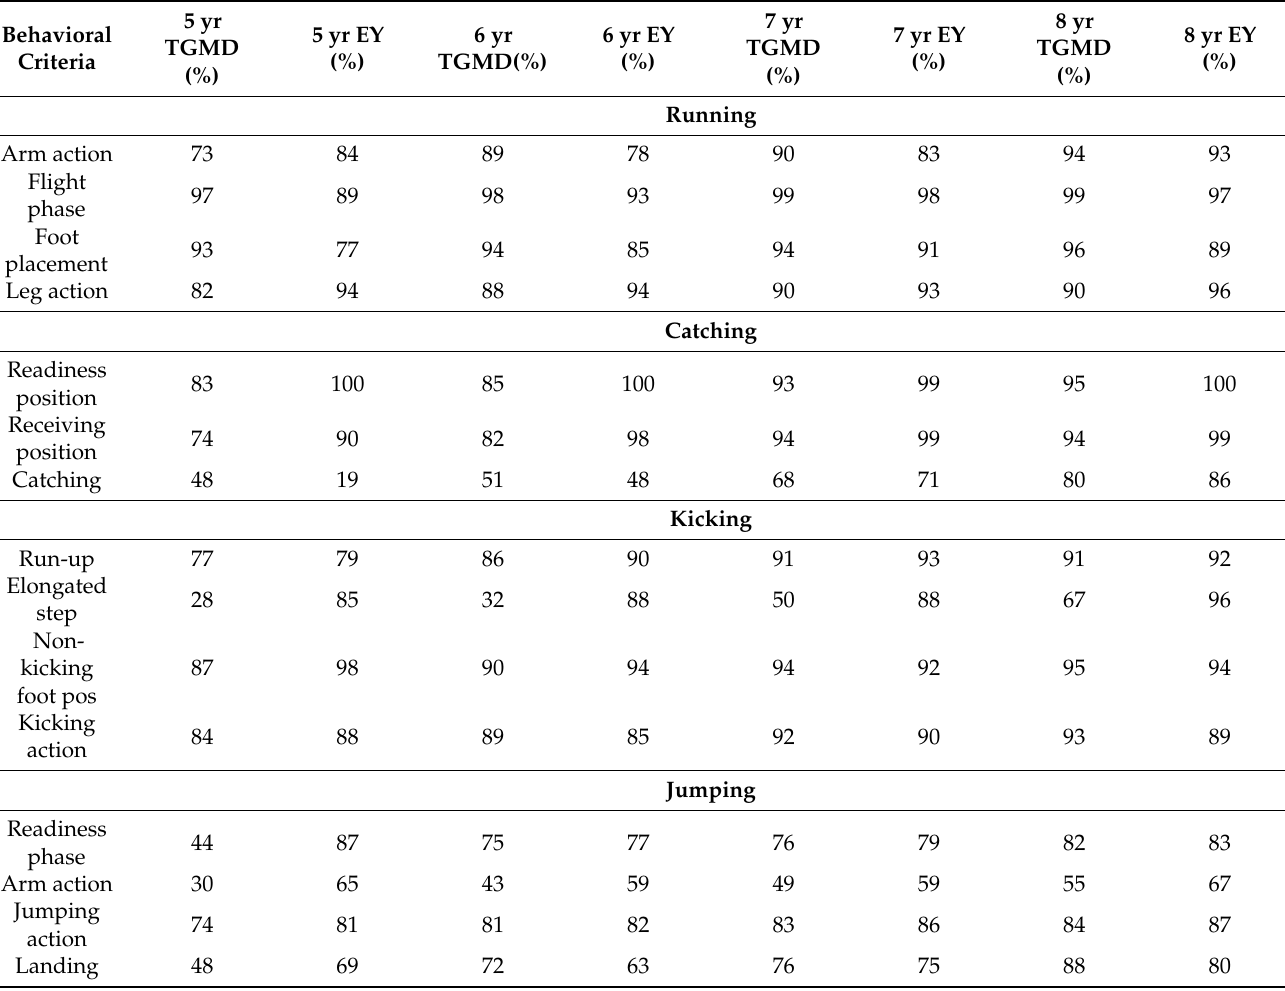
Table 4. Percentage mastery of the behavioral criteria by five- to eight-year-olds compared to TGMD-2 mastery percentages.